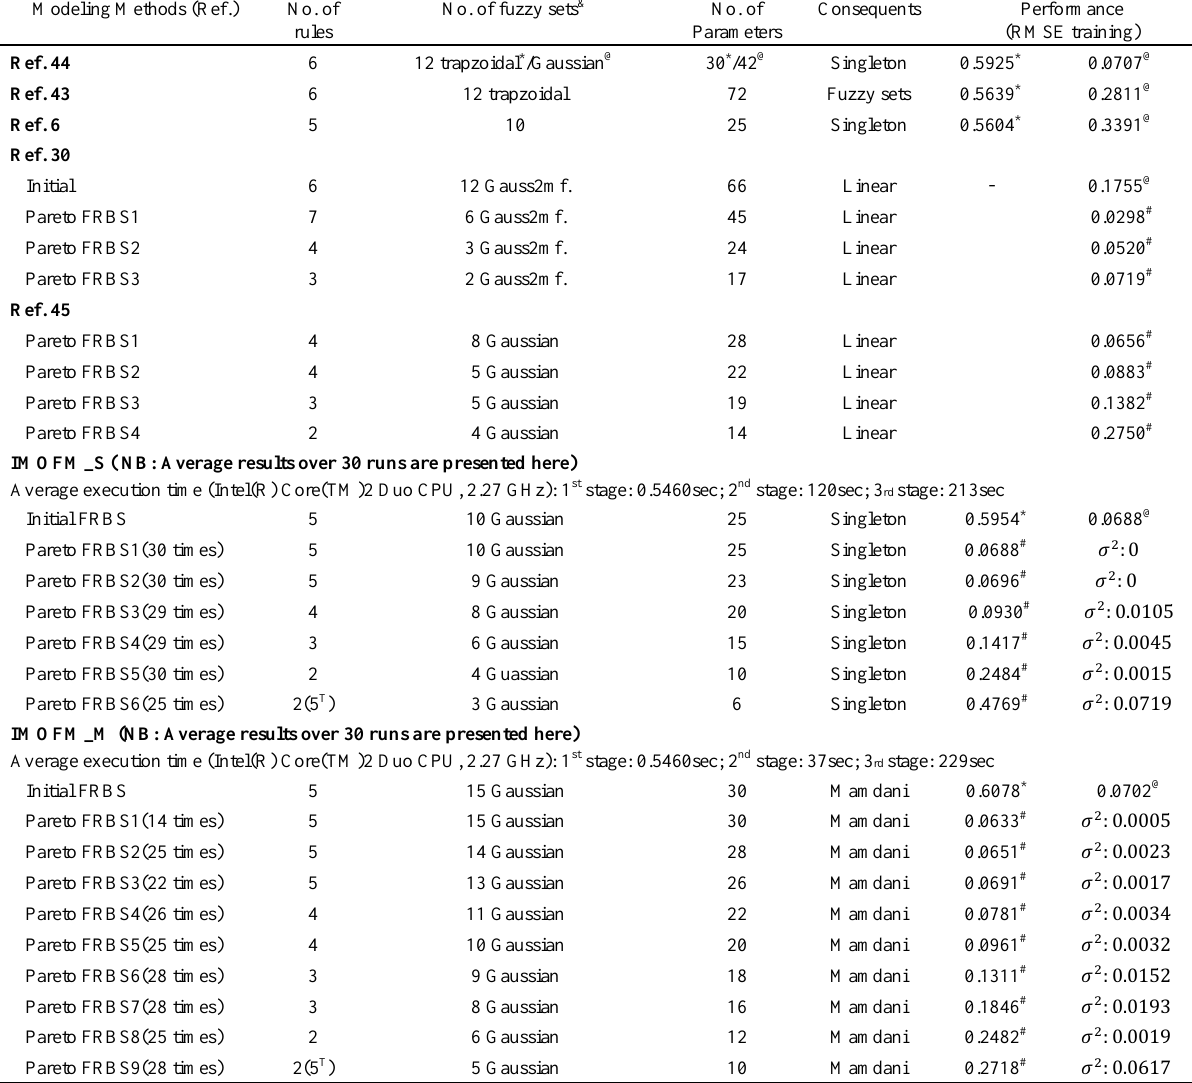
Table 1. Comparisons of the predictive performance of different modeling methods. Modeling Methods